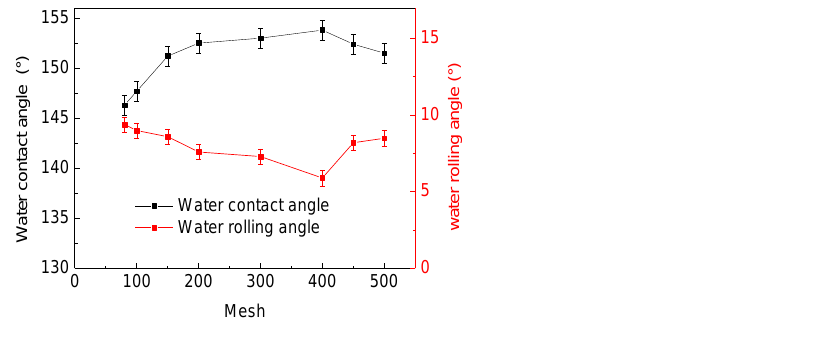
Figure 5. Trend chart for the influence of different aperture filters on contact angle and rolling angle of coatings. of